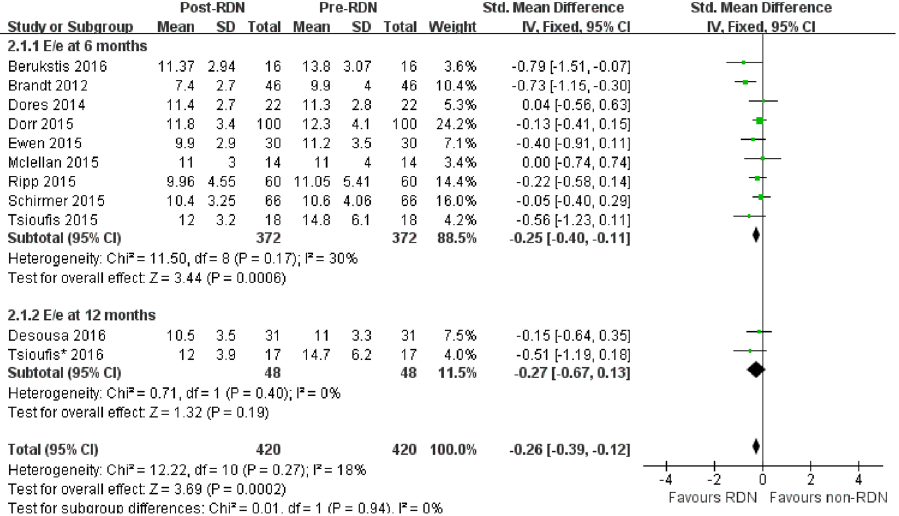
Figure 5. Forest plot of RDN changing E/e’ in observational studies, stratified by follow up duration.